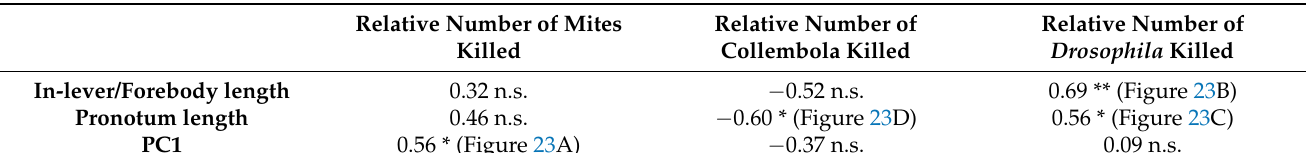
Table 4. Spearman correlation matrix of variables analysed with phylogenetic independent contrast. Only variables with significant correlations are shown (significance levels: ** p < 0.01, * p < 0.05, n.s. not significant), sample size N = 14.